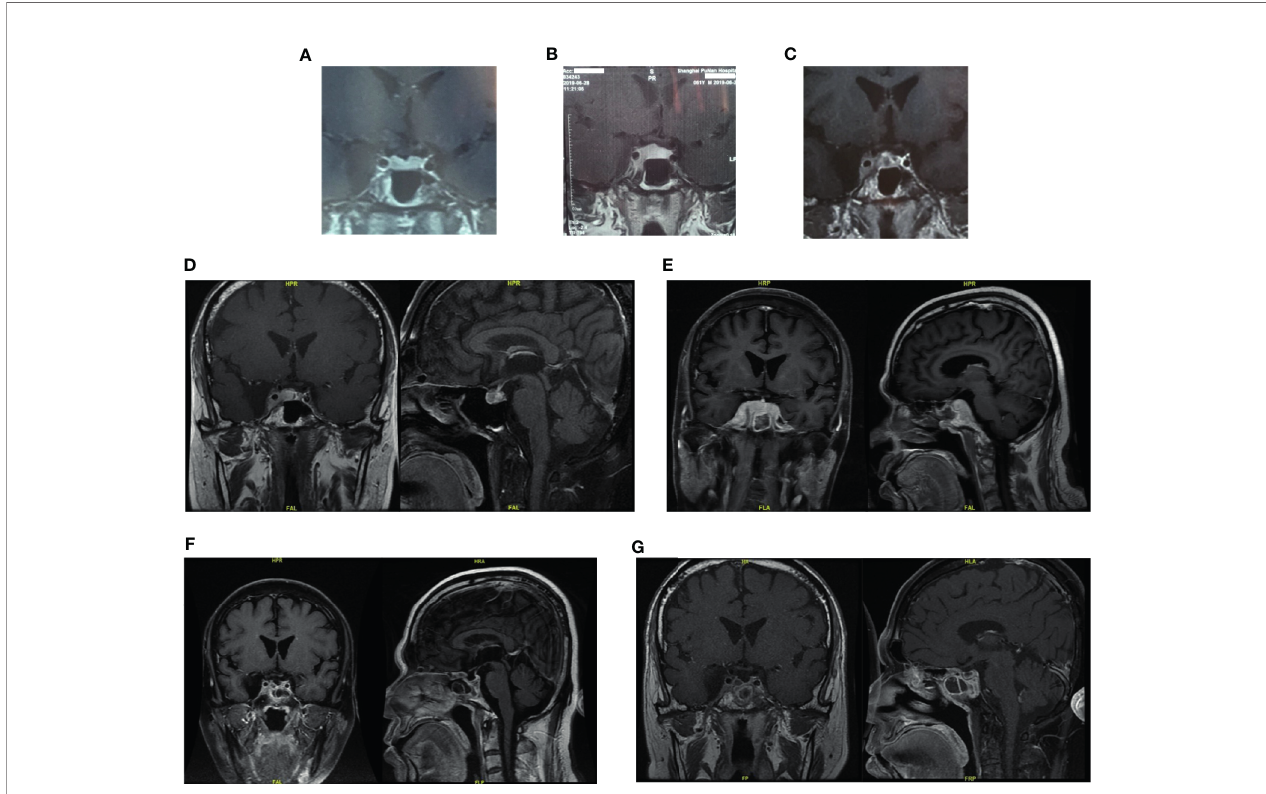
FIGURE 1 | The pituitary images in different period of Case 1. (A, B) Pituitary magnetic resonance imaging (MRI) 10 and 5 months ago both demonstrated suspected “ pituitary microadenoma ” on the right side. (C) Three months ago, enhanced MRI showed the mass in sella turcica enlarged to 1.3 × 0.9 cm, involving the right cavernous sinus and internal carotid artery. (D) One months ago, the pituitary MRI showed the mass might be “ pituitary macroadenoma ” (12.7 × 6.7 × 11.1 mm, demonstrating equal T1 and equal T2 signal with slightly homogeneous enhancement) in the sellar region with the right cavernous sinus invasion (Knosp IV). (E) Pituitary MRI reexamination half months after biopsy surgery showed the mass enlarged compared with before, involving bilateral cavernous sinus. (F, G) Enhanced head MRI + DWI and Pituitary gland plain scan + enhanced MRI showed the mass was signi fi cantly smaller than before after three months ’